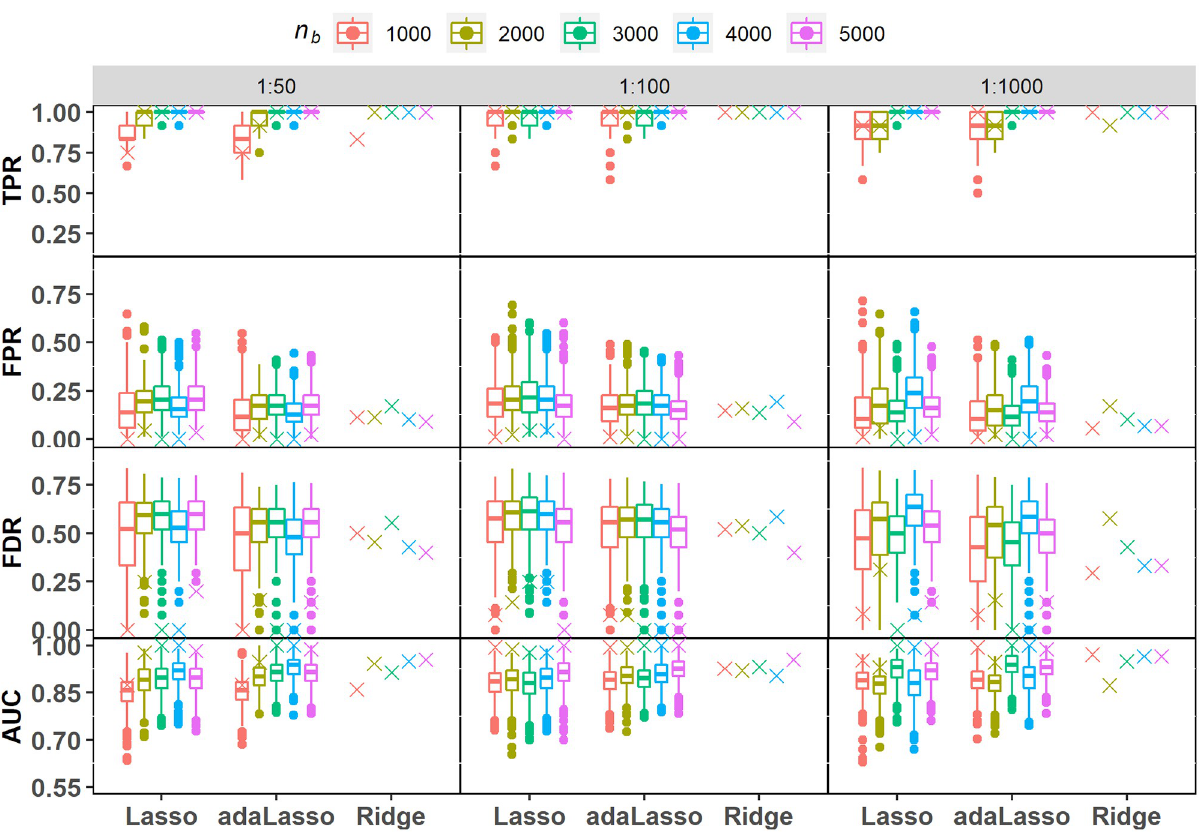
Fig 5. Simulation under COR-12. Performance metric scores for variable selection based on the SVRS algorithm (symbol x) and corresponding distributions across 500 individual fits of each regularization model with imbalance ratios 1:50, 1:100 and 1:1000. Performance scores for individual ridge regression fits are not applicable as it does not perform automatic variable